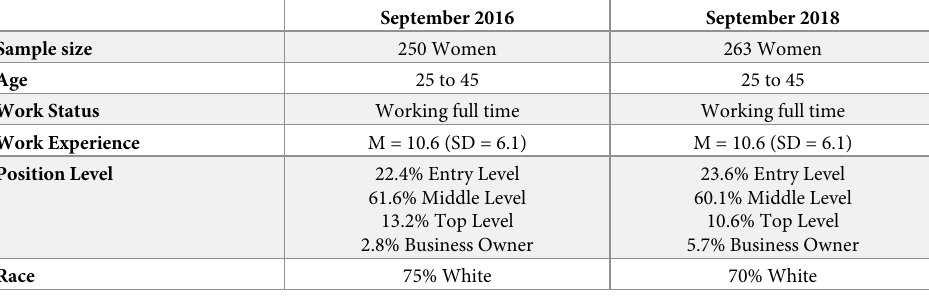
Table 1. Comparison of Qualtrics panel samples from September 2016 and September